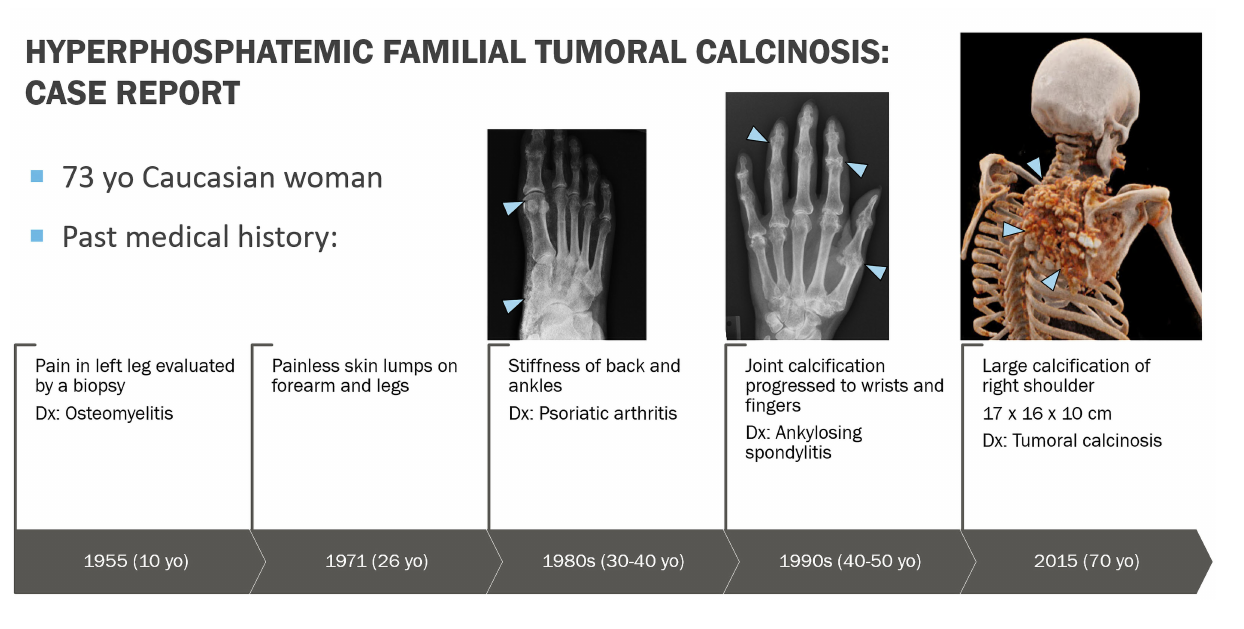
FIGURE 1 | Graphic representation of clinical course. At age 10 years, patient experienced unusual pain in her left leg that represented hyperostosis-hyperphosphatemia syndrome, which was evaluated with a biopsy and misdiagnosed as osteomyelitis. At age 26 years, she started noticing painless skin lumps on her forearm and legs. In her 30s, she started experiencing back pain and joint stiffness in her ankles and fingers. She was then evaluated by a rheumatologist and was diagnosed with an ill-defined rheumatologic disorder, possibly psoriatic arthritis. Over the next 30 years, the arthritis slowly progressed to involve almost all joints of her body. Eventually this was determined to be an aggressive form of osteoarthritis, currently felt not to be related to underlying HFTC. In 2015, a large bump appeared around her right shoulder, which was initially thought to be a sarcoma. Upon biopsy, bone calcifications were found with the possibility of tumoral